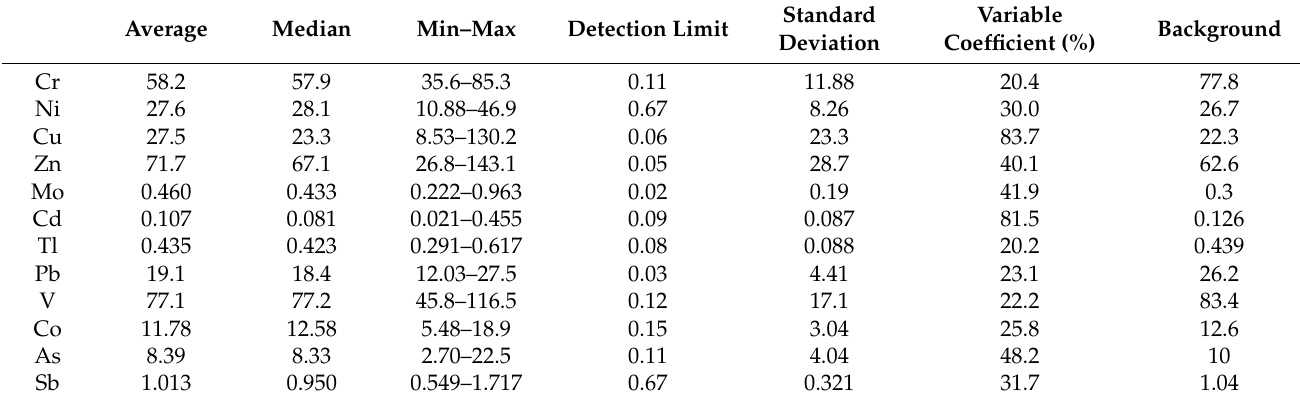
Table 2. The content of PTEs in the surface sediments of the Taipu River